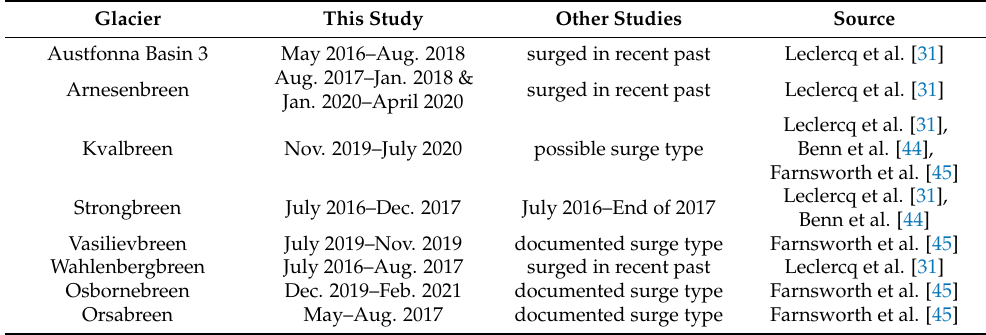
Table 4. Comparison of findings in this study to other recent studies. If direct measurements were taken, the timing of the corresponding study is given. Leclercq et al. [31] measured the backscatter intensity change from 2018–2019, and increases and decreases linked to surge activity that most likely represent the same surges found here. If a surge was detected in their study, it is denoted as “surged in recent past”, since a direct derivation regarding the timing is not possible. If no recent study was found, the likeliness or documentation of a past surge is taken as